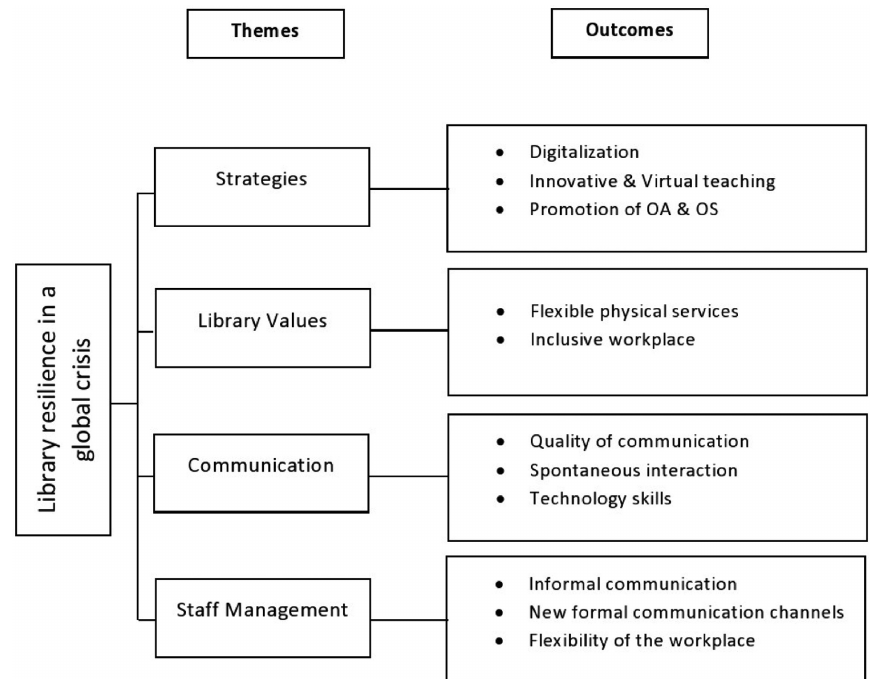
Fig. 1: Categorization and thematic